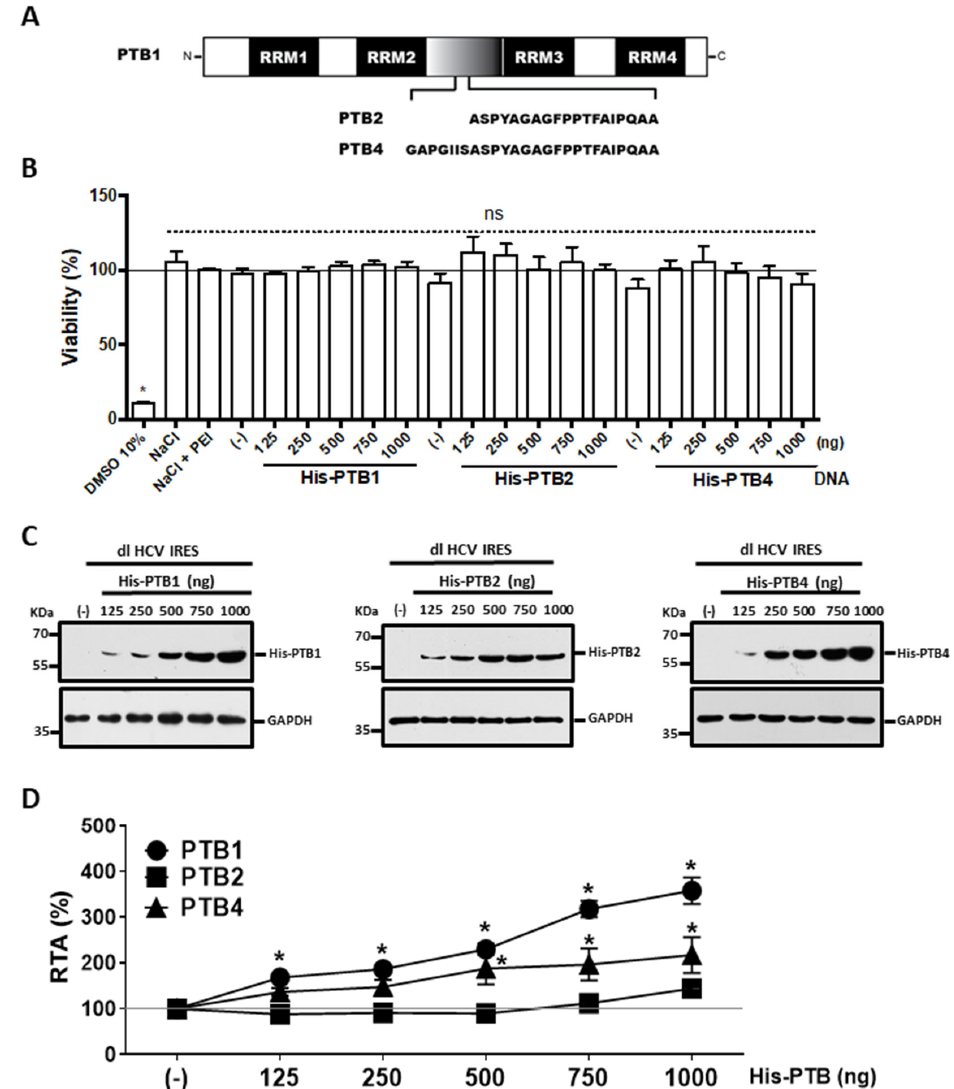
Figure 2. HCV IRES activity is stimulated in HuH ‐ 7 cells by PTB1 and PTB4, but not by PTB2. ( A ) Schematic representation of PTB isoforms showing the positions of the four RRMs. PTB2 and PTB4 differ from PTB1 by the insertion of 19 or 26 amino acids, respectively. ( B , D ) HuH ‐ 7 cells were transfected with the dl HCV IRES plasmid, the pcDNA3.1 LacZ control DNA (efficiency of transfection), and different concentrations (as indicated) of a vector expressing a His ‐ tagged version of PTB1, PTB2, or PTB4. An empty pSP64 ‐ Poly(A) vector was used as the negative control ( ‐ ). ( B ) The viability of HuH ‐ 7 cells was determined by measuring the cellular metabolic activity using the MTS assay. Dimethylsulfoxide (DMSO, 10%) was used as a control for cell death. ( C ) The expression of the His ‐ tagged proteins was confirmed by Western blotting using an anti ‐ His antibody ( α His). GAPDH was detected using an anti ‐ GAPDH antibody ( α GAPDH) as a loading control. ( D ) Luciferase activities were measured and expressed as RTA(%) relative to the activity measured in the HuH ‐ 7 cells transfected with dl HCV IRES, pcDNA3.1 LacZ, and pSP64 ‐ Poly(A) set to 100%. The values correspond to the means (±SEM) from three independent experiments each conducted in duplicate. Statistical analysis was undertaken by the ANOVA test, followed by Dunnett’s multiple comparisons tests; * p < 0.05 vs. the negative control; and ns, not significant.